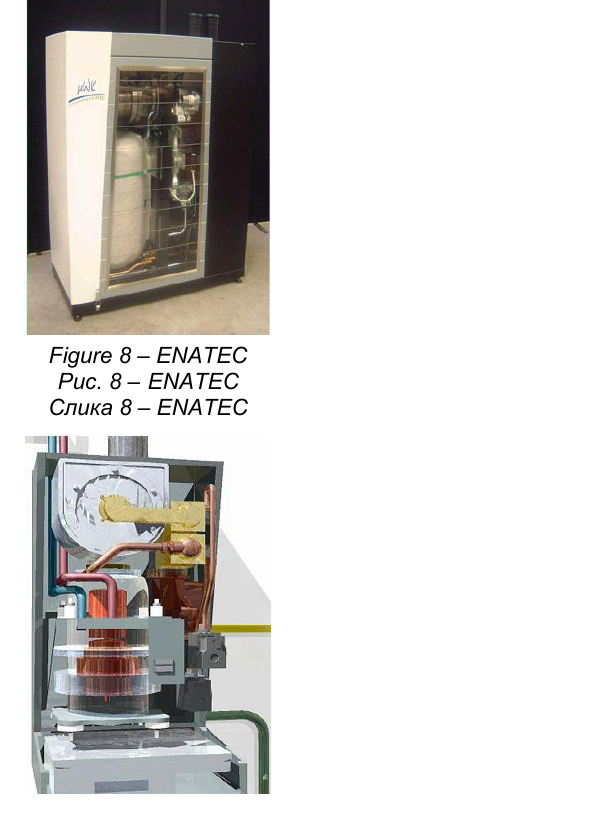
Figure 9 – The cross-section of the cogeneration plant, Microgen